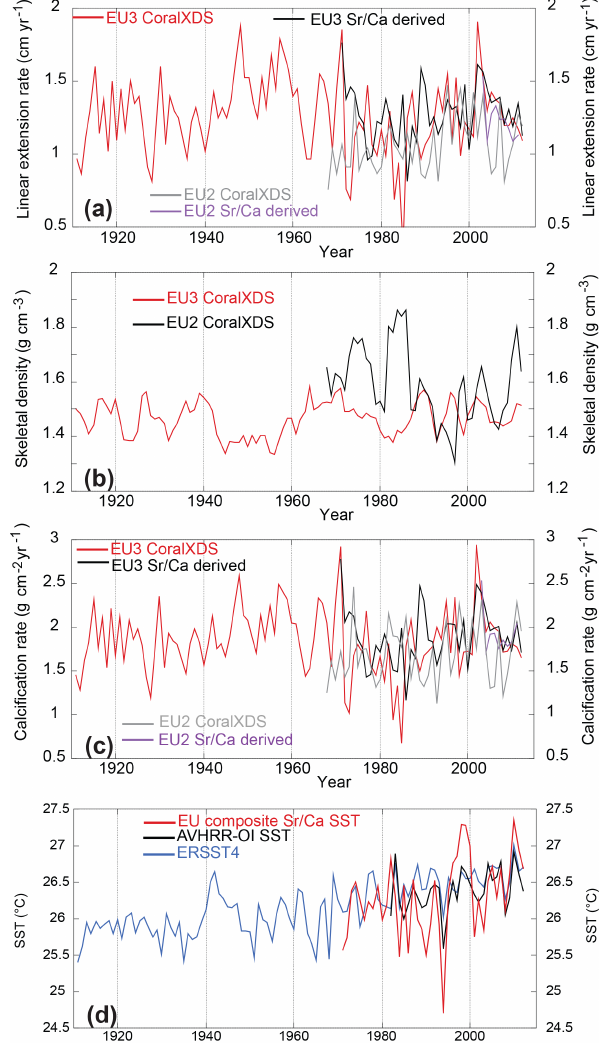
Figure 2. Mean annual coral growth parameters of cores EU3 and EU2 compared to coral composite Sr / Ca SST reconstruction, AVHRR-OISSTv2 (Banzon et al., 2016), and ERSSTv4 (Liu et al., 2015). Mean annual (a) EU2 and EU3 linear extension rate (CoralXDS and Sr / Ca derived), (b) EU2 and EU3 skeletal density (CoralXDS), (c) EU2 and EU3 calcification rate (CoralXDS and Sr / Ca derived), and (d) SST time series (ERSSTv4, AVHRR-OI SSTv2, EU Sr / Ca SST